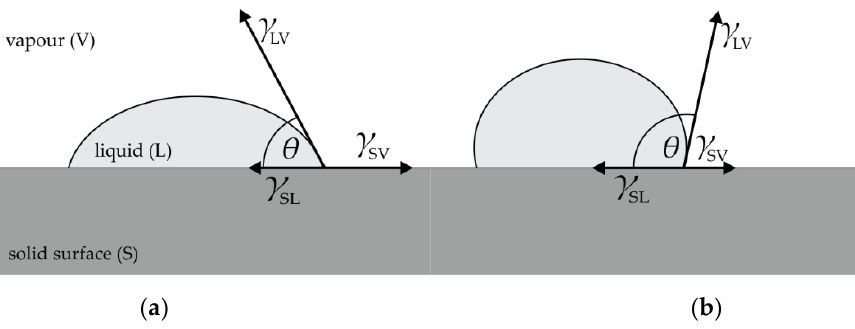
Figure 1. Contact angles of liquids on ( a ) non-hydrophobic and ( b ) hydrophobic surface.